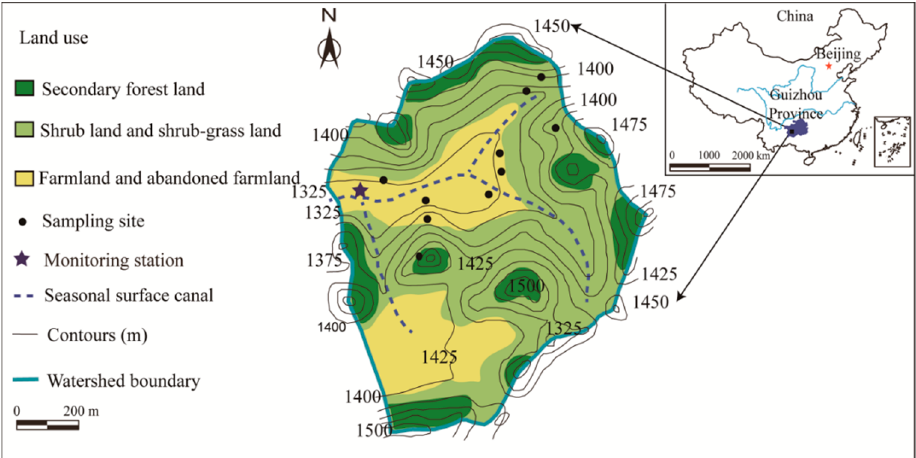
Figure 1. Land use and sampling sites of study area.